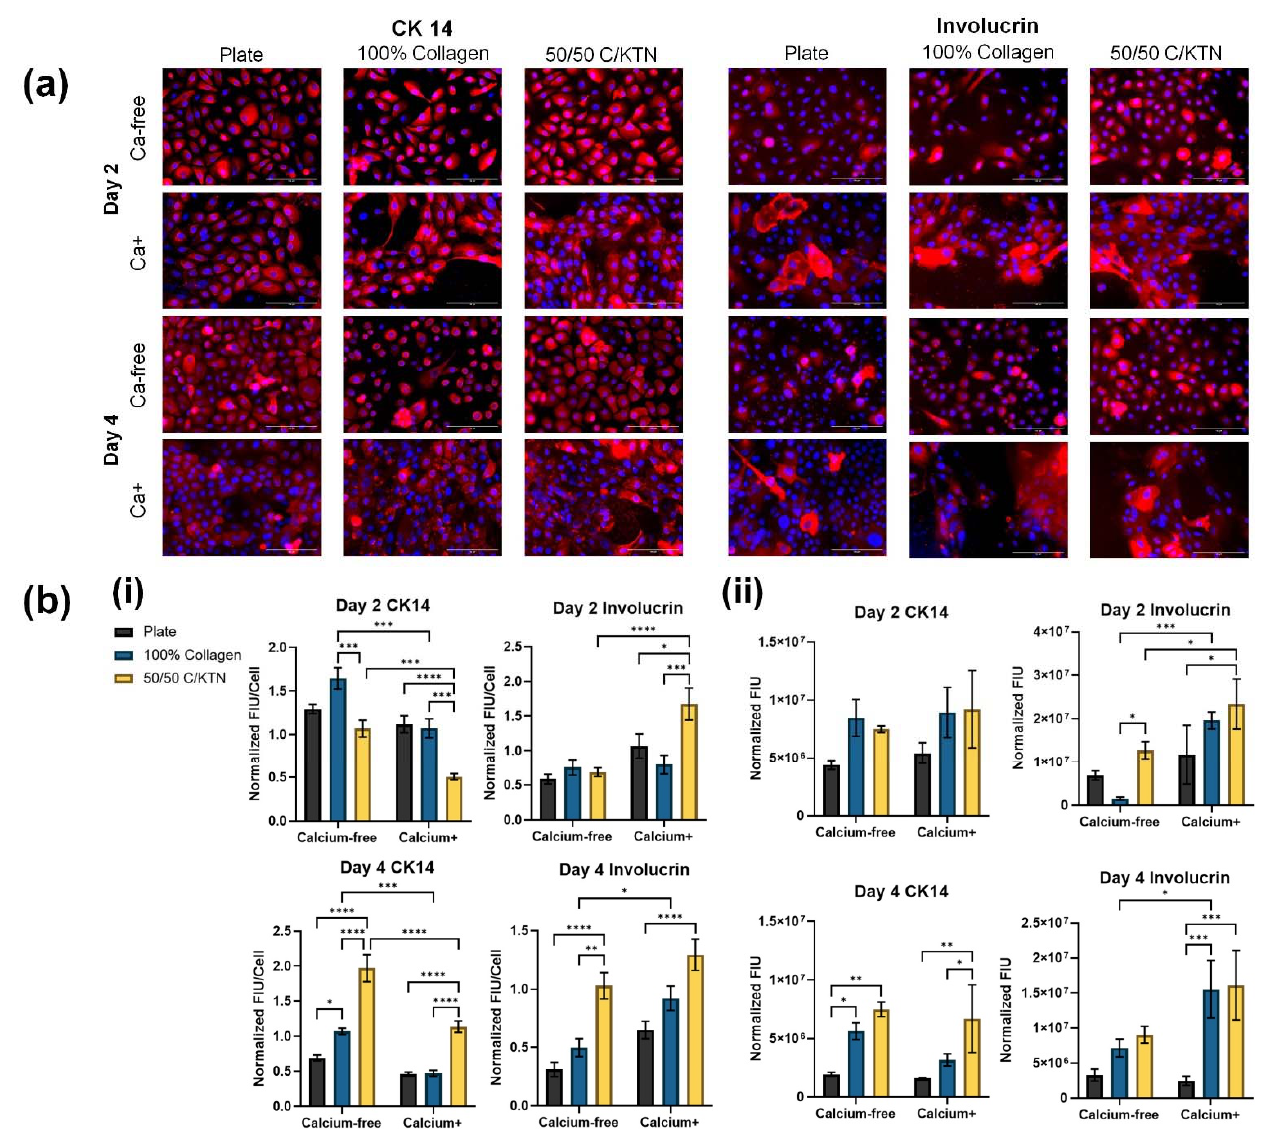
Figure 5. CK14 and involucrin staining and analysis of 2D monolayer samples. Keratinocytes seeded on the plate, 100% collagen hydrogels, and 50/50 C/KTN hydrogels were fixed, permeabilized, and stained for CK14 and involucrin at days 2 and post-calcium switch, with half of the samples still cultured in Ca-free medium ( a ). Images were analyzed ( b ) by CTCF of the marker ( i ) and the total fluorescence intensity per image ( ii ), which was normalized to the DAPI CTCF and the DAPI cell count, respectively. In general, CK14 was expressed significantly more in Ca-free samples when cells were analyzed individually. Involucrin expression was increased with Ca+ media with significantly higher involucrin expression observed with cells seeded on top of 50/50 C/KTN hydrogels. FIU/cell and total FIU is displayed as average ± SEM and SD, respectively. Two-way ANOVA was conducted with n = 3; * = p < 0.05, ** = p < 0.01, *** = p < 0.001, **** = p < 0.0001. Scale bar = 100 µm. Table 4. Comparison of fluorescence intensity of differentiation markers between time points within each group. Two-way ANOVA was performed with n = 4 with 3 separate experiments. * = p < 0.05, ** = p < 0.01, *** = p < 0.001, **** = p < 0.0001, ns = not significant.